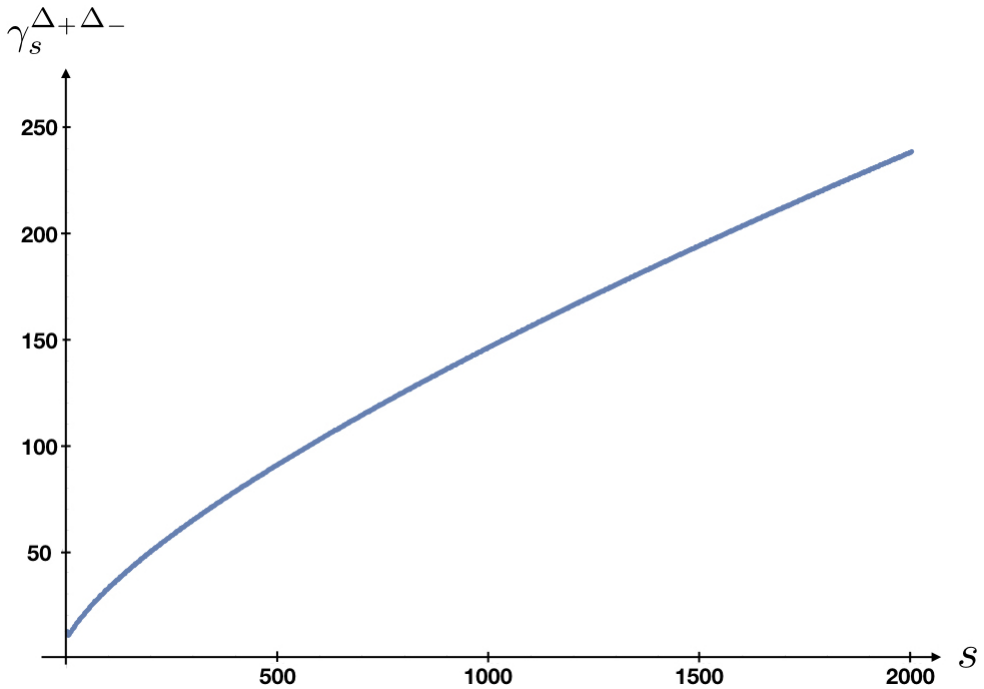
Figure 11. Plot of the re-summation of the contributions to the anomalous dimension from the di(cid:11)erence of s (cid:0) ( s 0 0) (cid:0) s bubble diagrams for the (cid:1) (cid:0) and (cid:1) + boundary condition on the scalar (cid:12)eld. The internal spin s 0 is summed over while the external spin s , which is displayed on the horizontal axis, is (cid:12)xed.